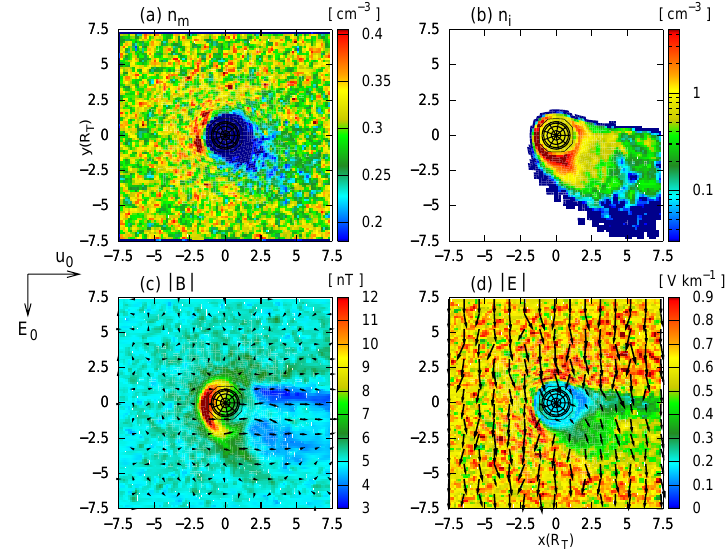
Fig. 8. Interaction between Titan’s ionosphere and a slightly super-alfv´enic, yet subsonic and submagnetosonic plasma flow – Cut through the equatorial plane. The physical quantities shown in the figure are the same as in Fig. 5. Mach numbers of the upstream plasma flow: M A =1.87 (alfv´enic), M S =0.57 (sonic) and M MS =0.55 (magnetosonic).